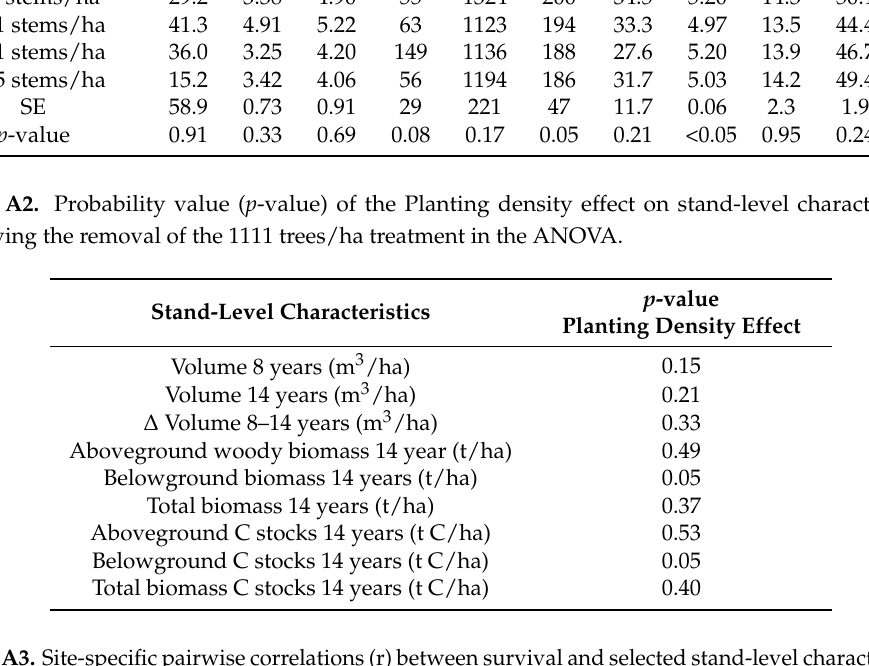
Table A3. Site-specific pairwise correlations (r) between survival and selected stand-level characteristics in hybrid poplar